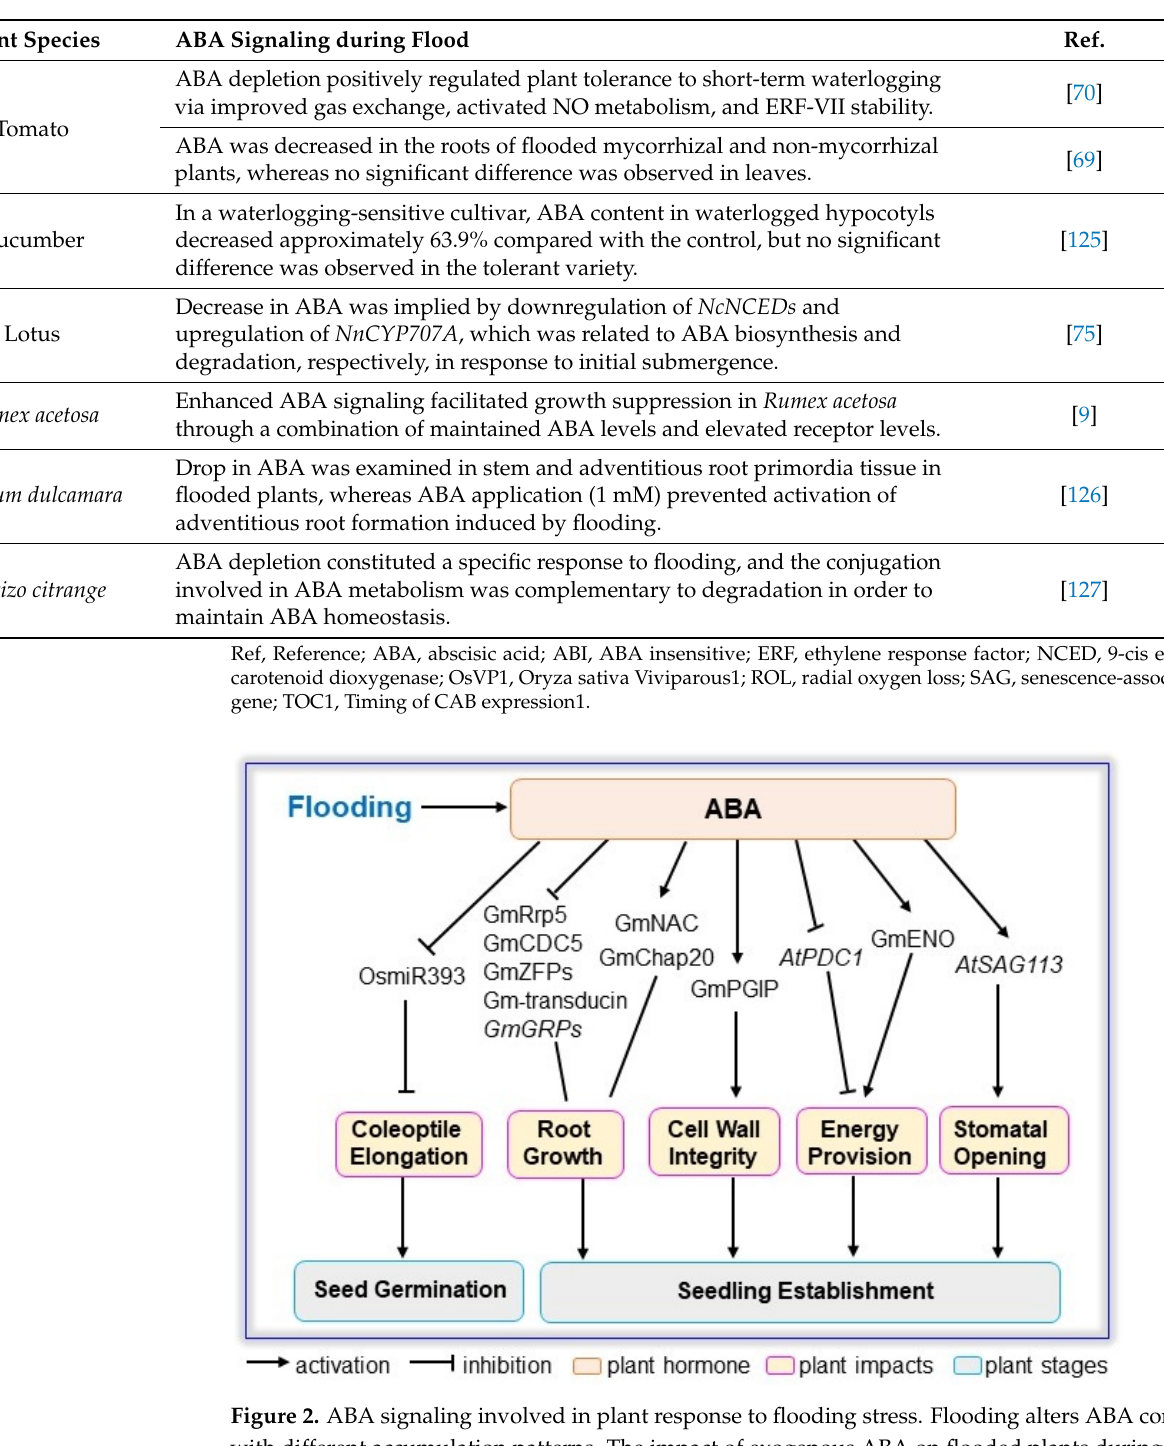
Table 3. ABA signaling in plants to flooding stress.